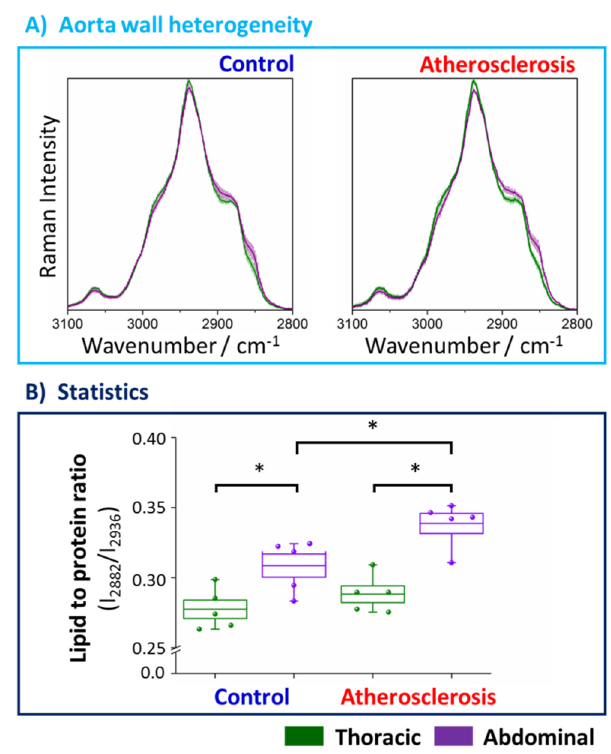
Figure 3. Averaged Raman spectra and the statistical analysis of the lipid to protein ratio of the thoracic and abdominal fragments of the aorta wall upon atherosclerosis development. Averaged Raman spectra of the thoracic (green) and abdominal (violet) aorta wall obtained from the control group (blue) and animals with developed atherosclerosis (red) ( A ). Spectra were normalized and presented with the standard deviation on each data point (accordingly lighter color). The analysis of the lipid to protein ratio ( B ) was calculated using the integral intensities of bands at positions 2882 and 2936 cm − 1 . Values were shown in the box plots: mean (horizontal line), SEM (box), minimal and maximal values (whiskers). The level of statistical significance: * p <0.05.